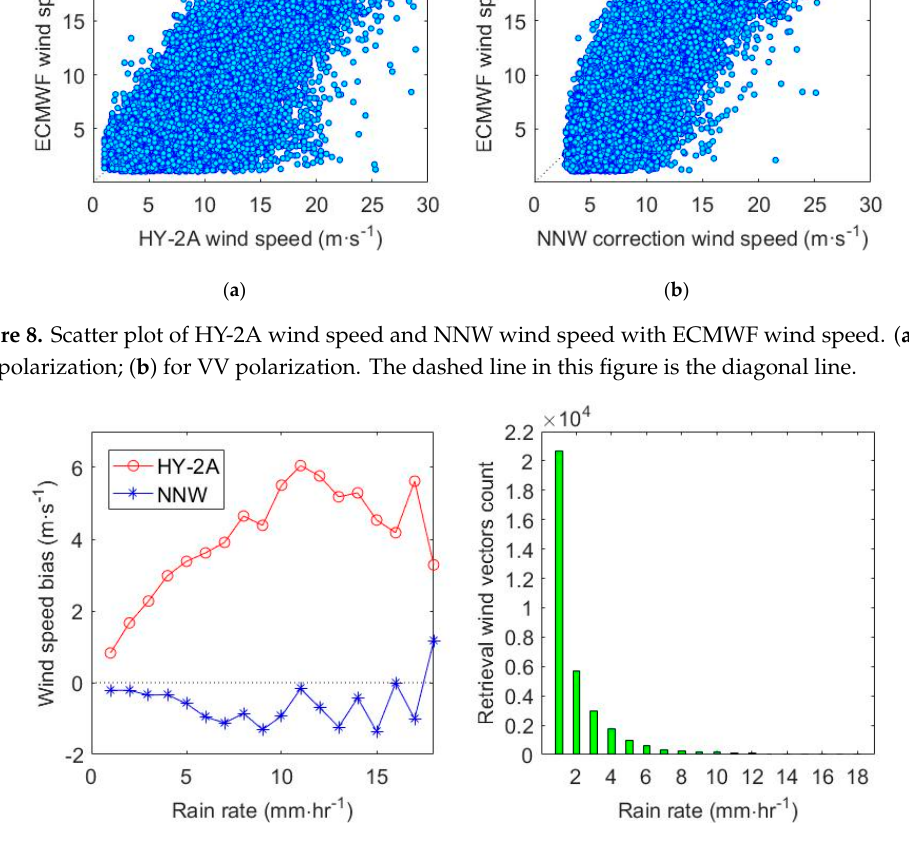
Table 5. The errors of HY-2A wind speed and NNW wind speed with ECMWF wind speed.